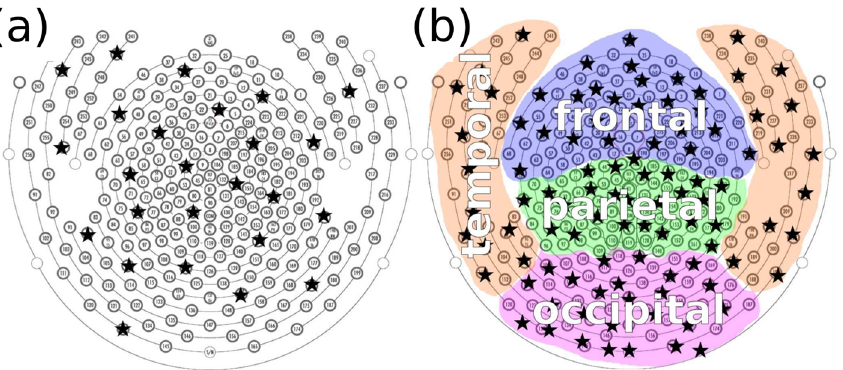
Fig 2. Channel selection from the high density (256 electrodes) EEG. The electrode layout is from manufacturer EGI [ 40]. The homogeneously distributed channel selection is shown for: a) analyses across the whole scalp; b) analyses restricted to a certain lobe. Chosen channels are indicated as black stars. See text for